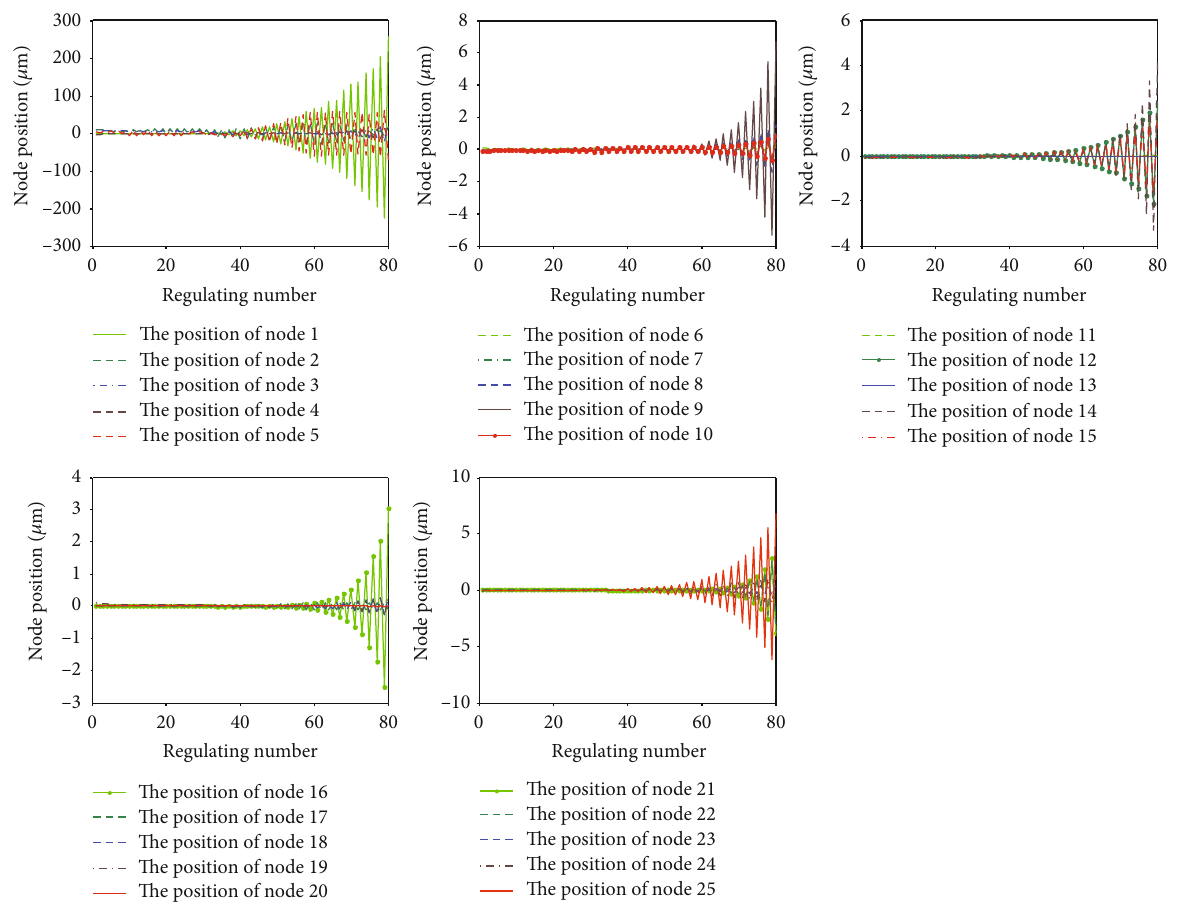
Figure 6: Q-learning adjustment curve with disturbance of